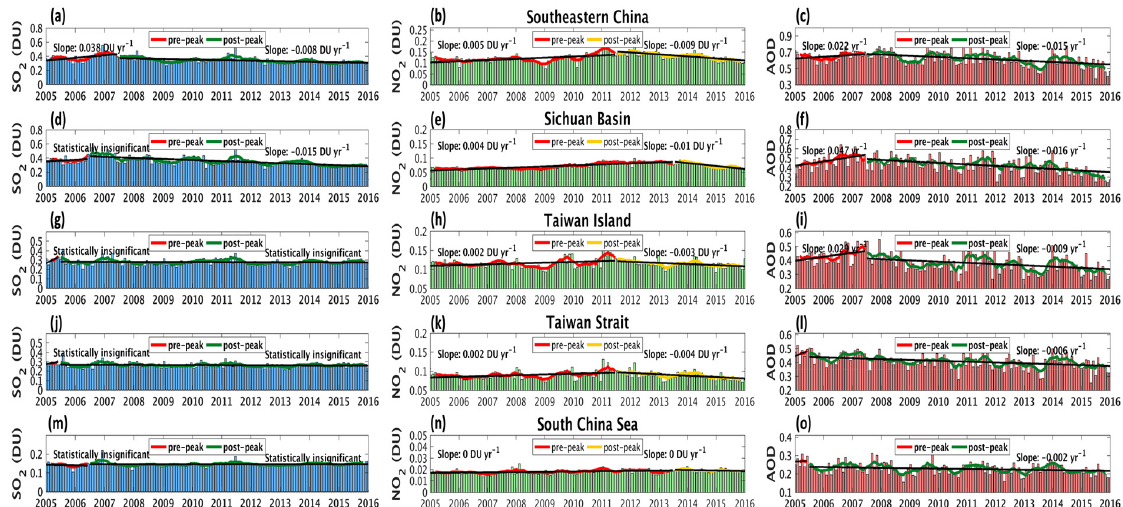
Figure 6. Five-month moving averaged seasonally adjusted time series of SO 2 , NO 2 , and AOD over ( a – c ) Southeastern China, ( d – f ) Sichuan Basin, ( g – i ) Taiwan Island, ( j – l ) Taiwan Strait, and ( m – o ) South China Sea. The pre-peak and post-peak trend lines are indicated by red and green lines, respectively, for SO 2 and AOD, and are indicated by red and yellow lines, respectively, for NO 2 . Besides, the seasonally adjusted data are also shown by histogram.